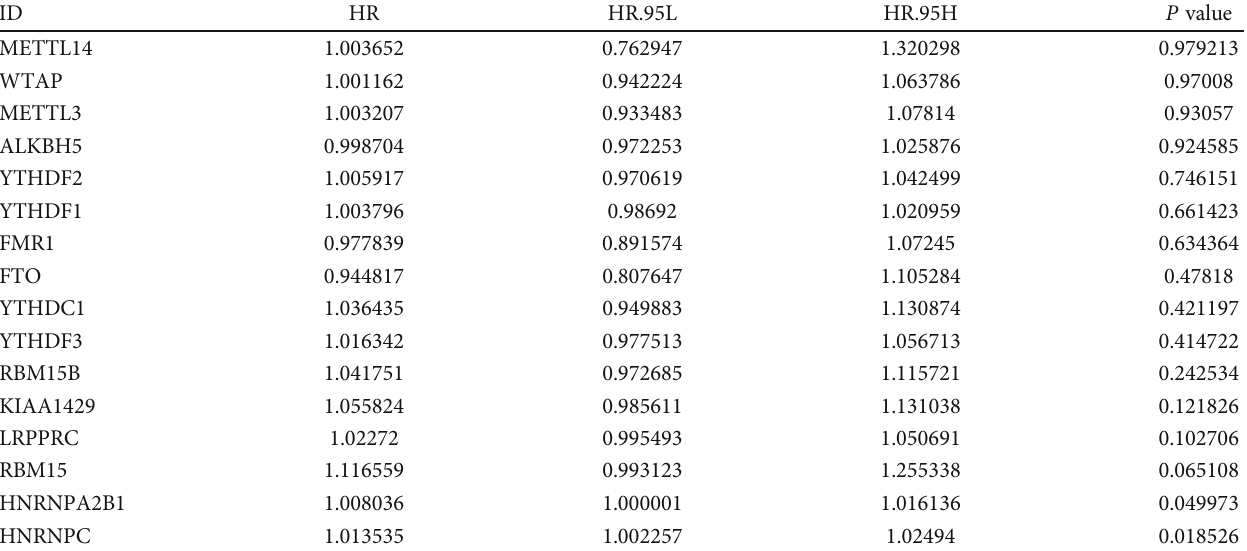
Table 3: Univariate Cox regression analysis of the TCGA training